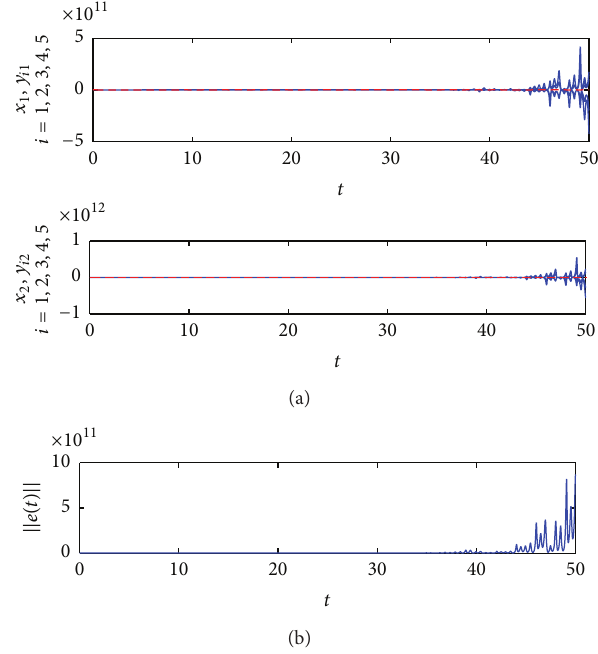
Figure 7: Evolution of (a) state trajectories of drive and response systems and (b) projective synchronization error without impulsive control when 𝜏(𝑡) = 0 .